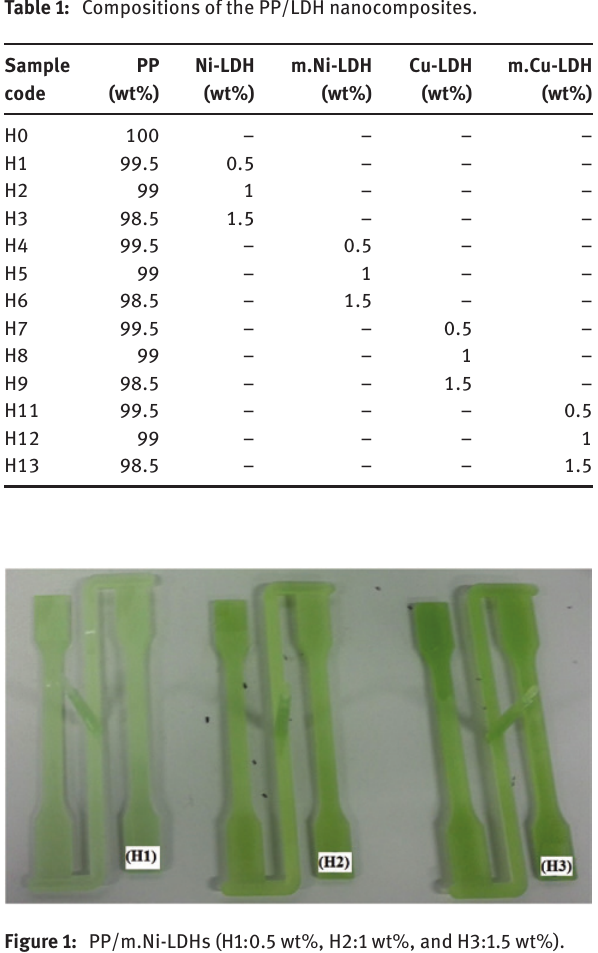
Figure 1: PP/m.Ni-LDHs (H1:0.5 wt%, H2:1 wt%, and H3:1.5